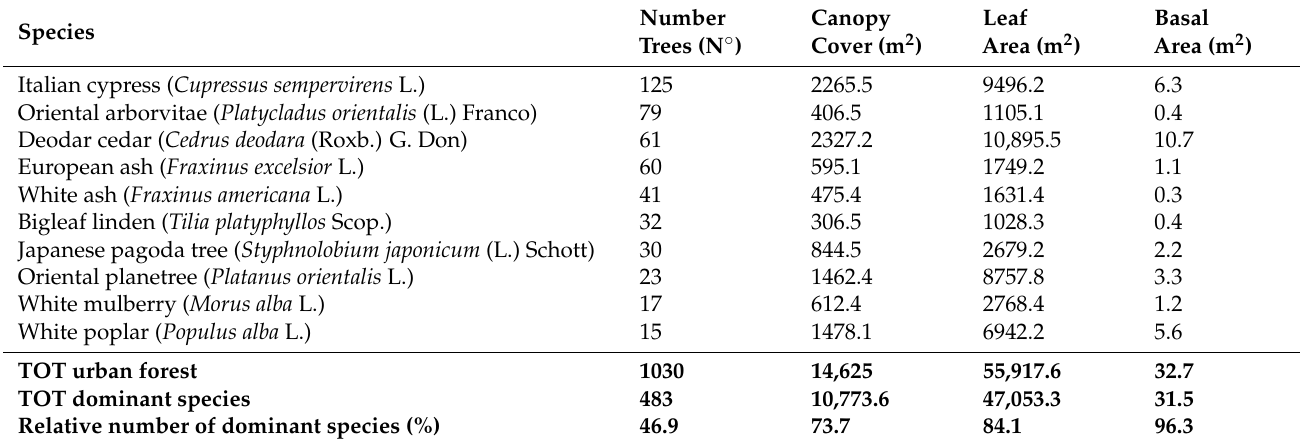
Table 1. Dominant species in RED Park with a relative number, canopy cover, leaf area, and basal area greater or equal to 1%, 300 m 2 , 1000 m 2 , and 0.3 m 2 .